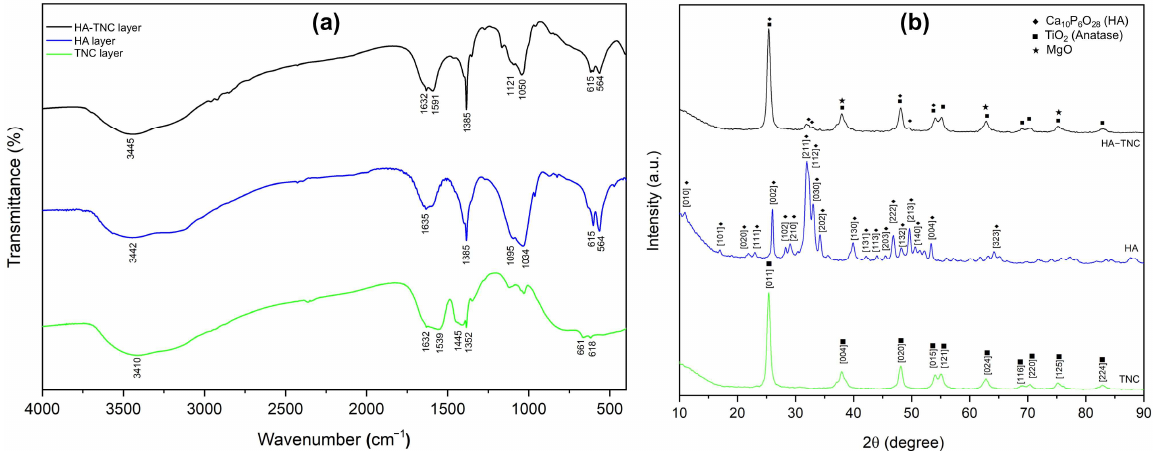
Figure 3. ( a ) FTIR spectrums and ( b ) XRD patterns of the TNC coating, HA coating, and HA-TNC coating. TNC